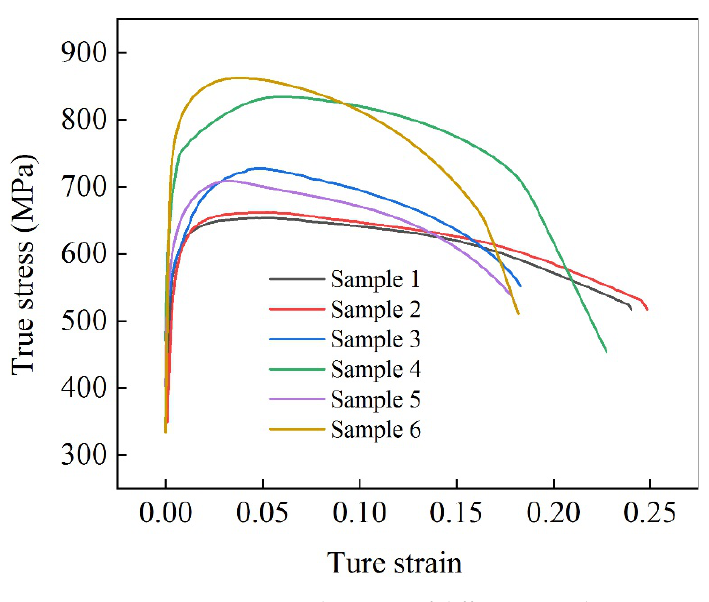
Figure 6. True strain-stress tensile curves of different samples at room temperature.